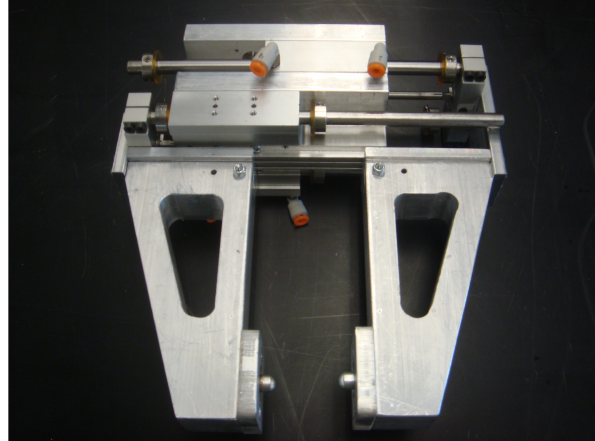
Figure 6. Prototype of parallel jaw gripper with spring actuated